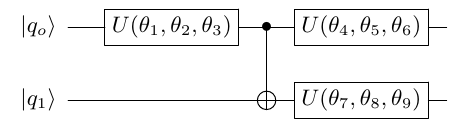
FIG. 3. Two-qubit heuristic circuit ansatz for H 2 in the VQE algorithm.